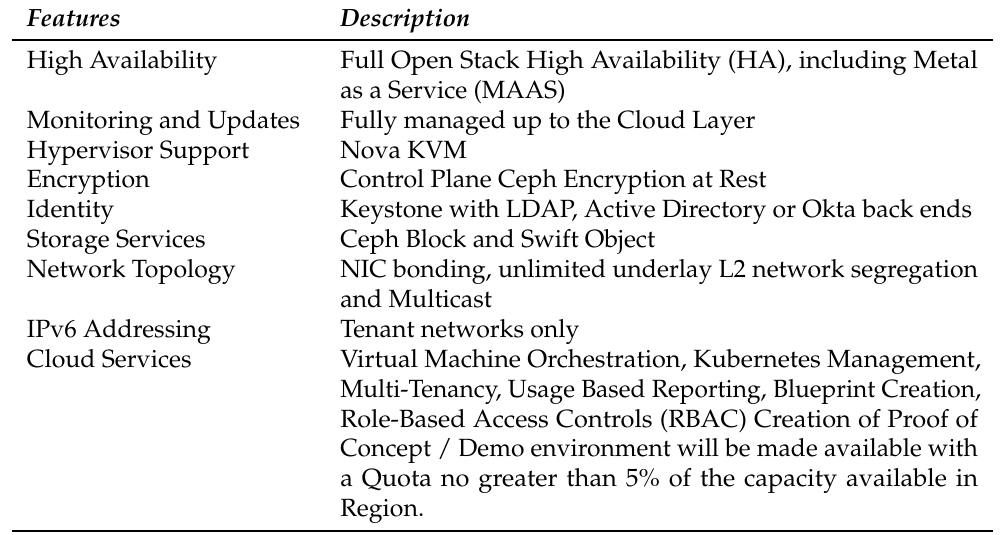
Table 6. Service